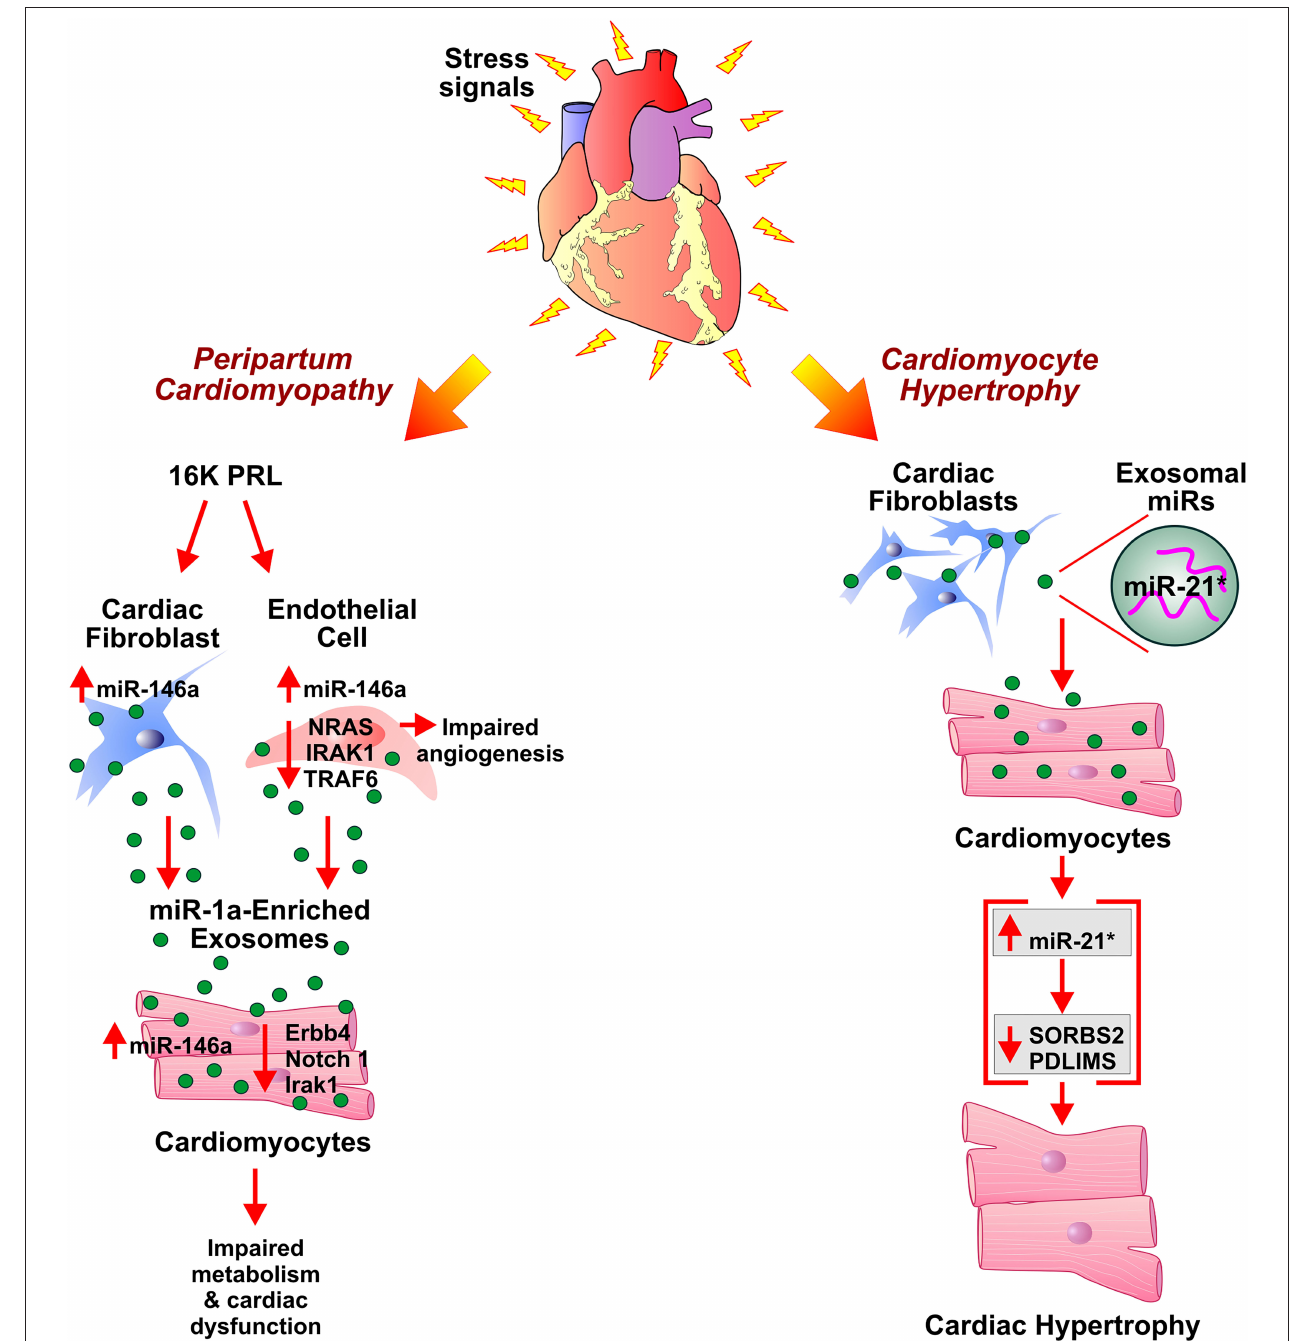
FIGURE 2 | Role of exosomes in development of peripartum cardiomyopathy and cardiac hypertrophy. Antiangiogenic 16 kDa fragment, 16K PRL, is generated in peripartum cardiomyopathy patients by cathepsin D-mediated cleavage of prolactin (PRL). 16K PRL stimulates cardiac fibroblasts and endothelial cells to secrete miR-146a enriched exosomes which upon transferring miR-146a to cardiomyocytes lead to impaired metabolism and angiogenesis in cardiomyocytes. miR-21*-enriched exosomes secreted by cardiac fibroblasts, under stress conditions, elevate miR-21* in cardiomyocytes. This results in cardiomyocyte hypertrophy by downregulation of SORBS2 and PDLIM5 expression